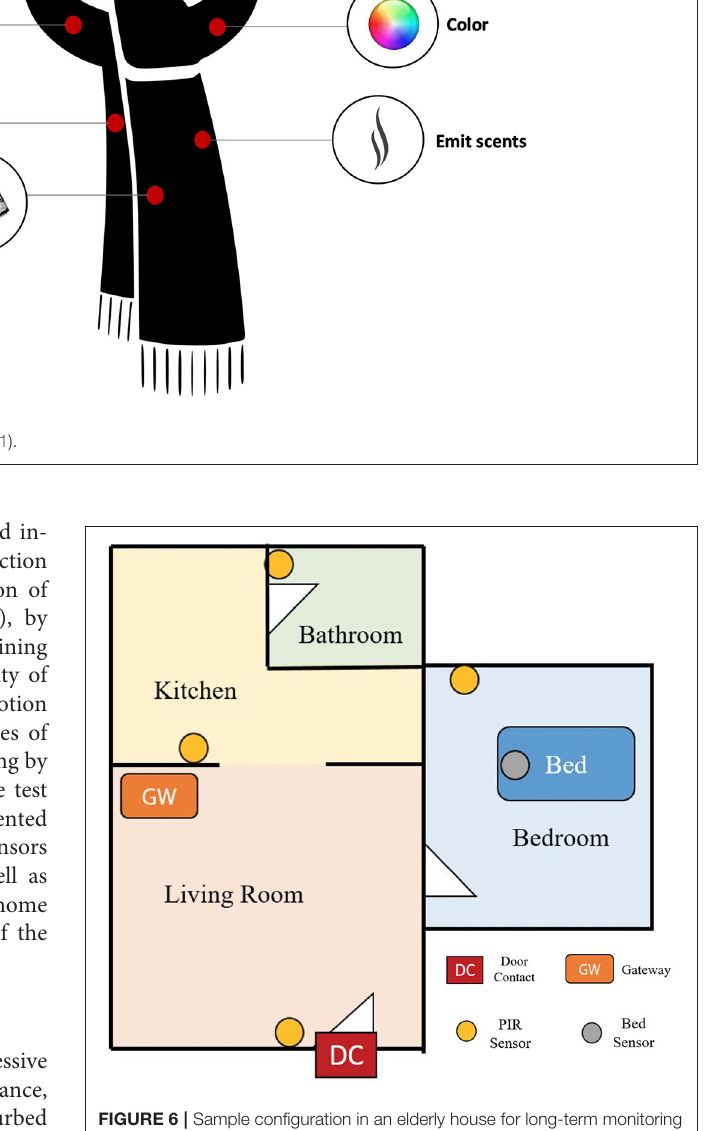
FIGURE 6 | Sample configuration in an elderly house for long-term monitoring of depression. [Modified from Kim et al., IEEE Sensors , 2017